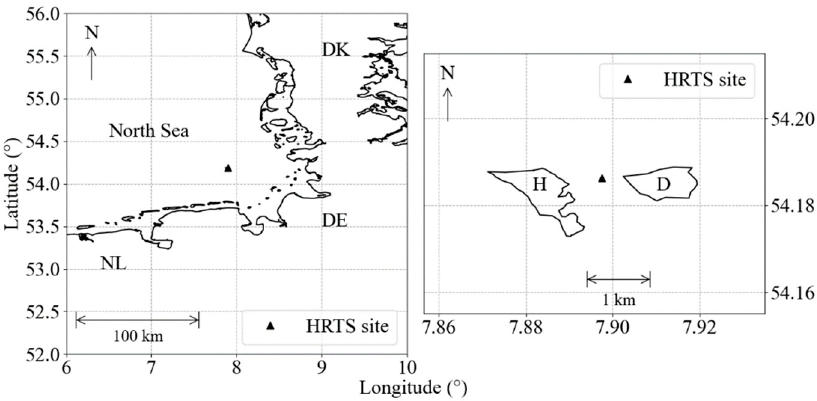
Figure 1. Helgoland Roads monitoring site position (black triangle) in the German Bight, between the Helgoland (H) and Dune (D) islands. Table 1. Statistical description of parameters used as determinants to predict chlorophyll-a concen- tration (target) after linear interpolation (std, min and max are standard deviation, minimum and maximum values,